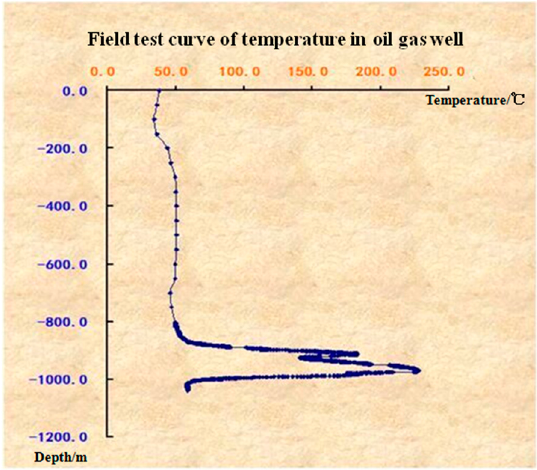
Figure 23. Temperature distribution down to 1100 m depth of well hole, measured by FBG sensors.